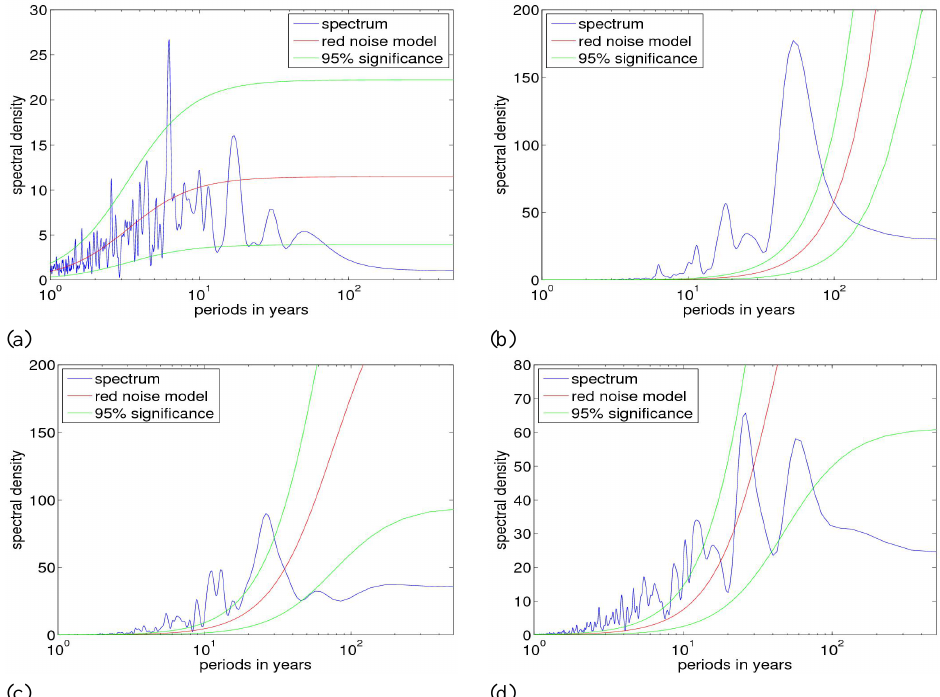
Fig. 11. (a) Power spectrum for the monthly-averaged PC 1 of the geopotential height at 833hPa model level for the coupled 800yr run. (b) The same as in (a) but for SST 0 over the ACC. (c) The same as in (b) but for PC 2. (d) The same as in (b) but for the Southern